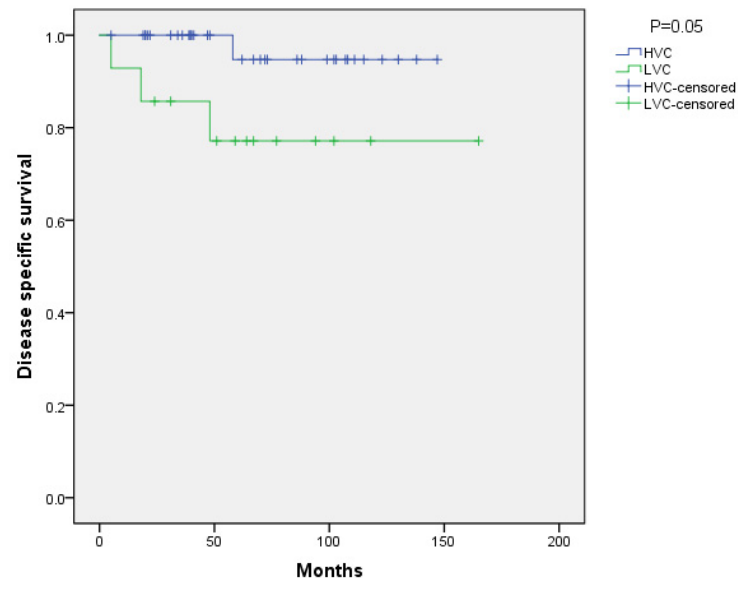
Figure 2. Disease specific